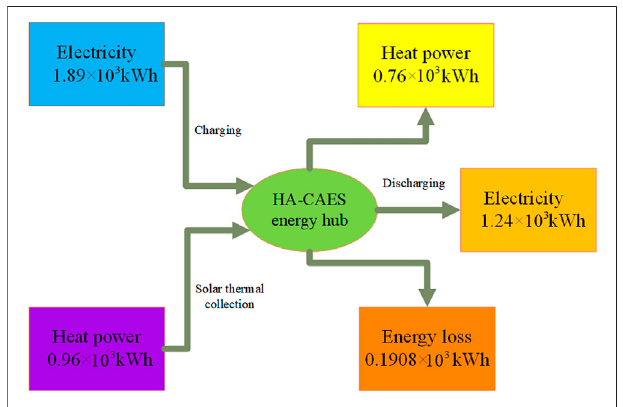
FIGURE 7 | The energy fl ow of 100kW